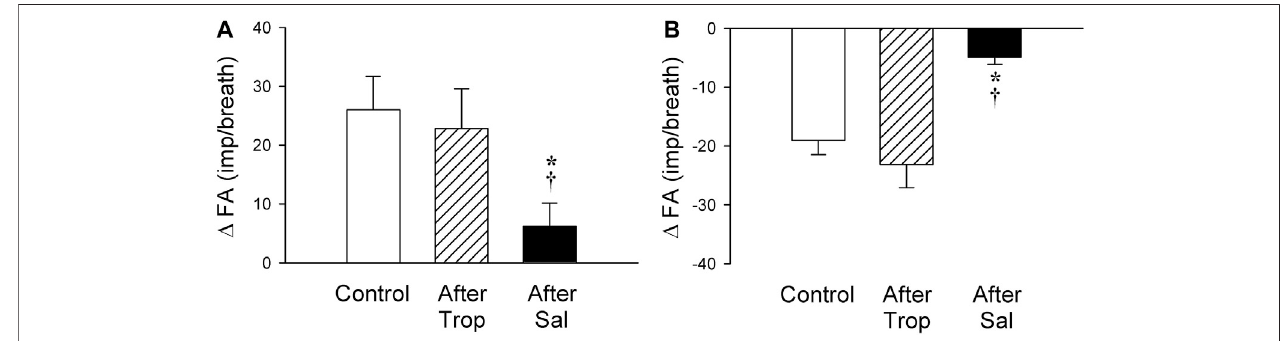
FIGURE 8 | Effect of pretreatments with Trop (15 μ g/kg) and Sal (0.5 mg/kg) on the afferent responses to i. v. injections of 5-HT (16 μ g/kg) in two subgroups of SARs selected based upon their individual responses to 5-HT, as described in Figure 7 : (A) stimulation (n = 6); (B) inhibition (n = 6). Only one SAR was studied in each animal. * and † , signi fi cantly different ( p < 0.05) from the control response and the response after pretreatment with Trop, respectively. Data are means ± SEM.